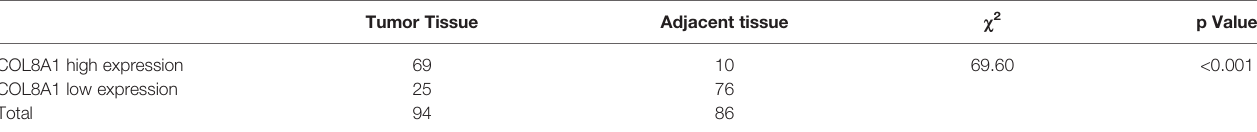
TABLE 1 | The expression of COL8A1 in Normal tissue and NSCLC by